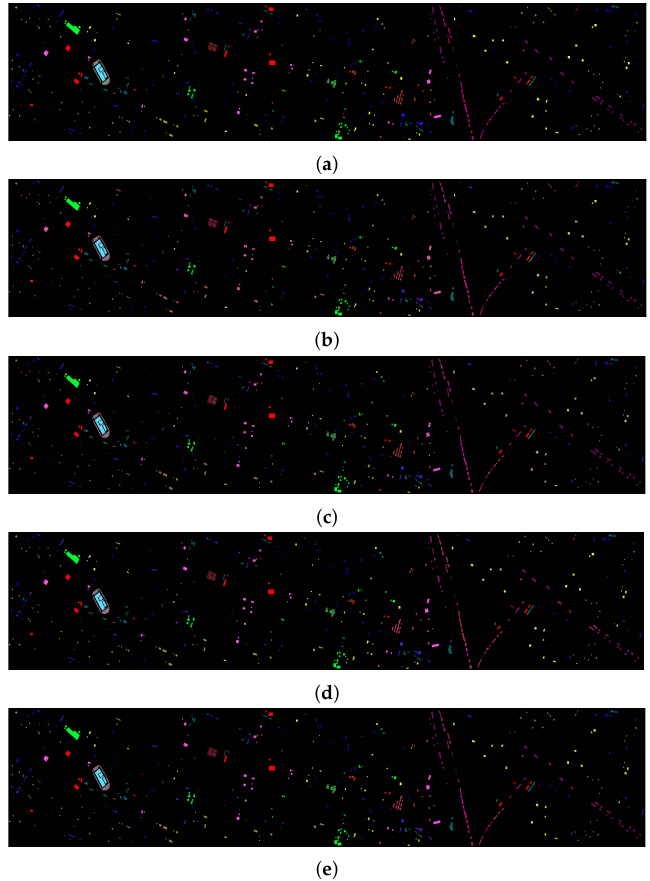
Figure 11. Houston. Classification maps of different models. ( a ) Pseudocolor images; ( b ) Model-1; ( c ) Model-2; ( d ) Model-3; ( e )